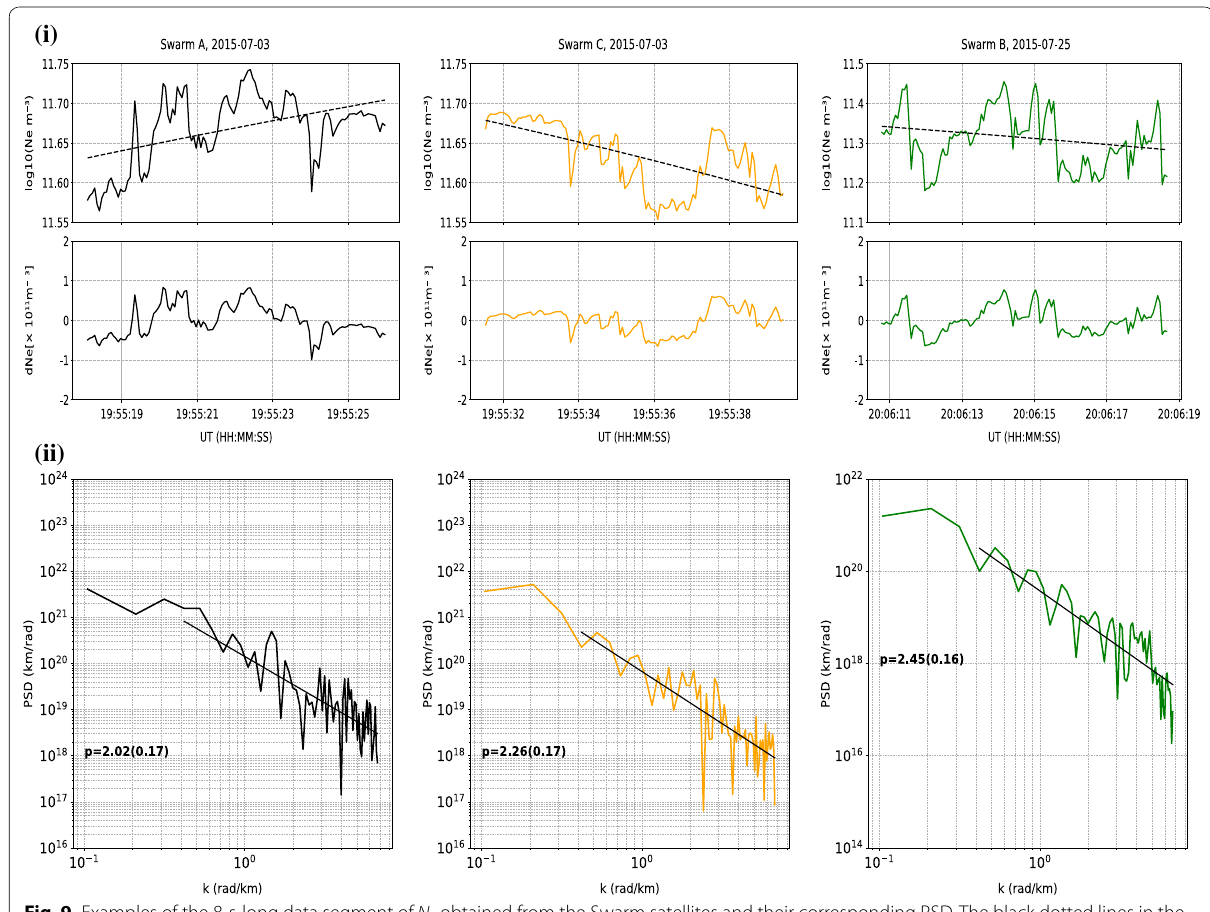
Fig. 9 Examples of the 8-s-long data segment of N e obtained from the Swarm satellites and their corresponding PSD. The black dotted lines in the top panels represent the mean of the raw data (or the trend line). The middle panels present the segments after